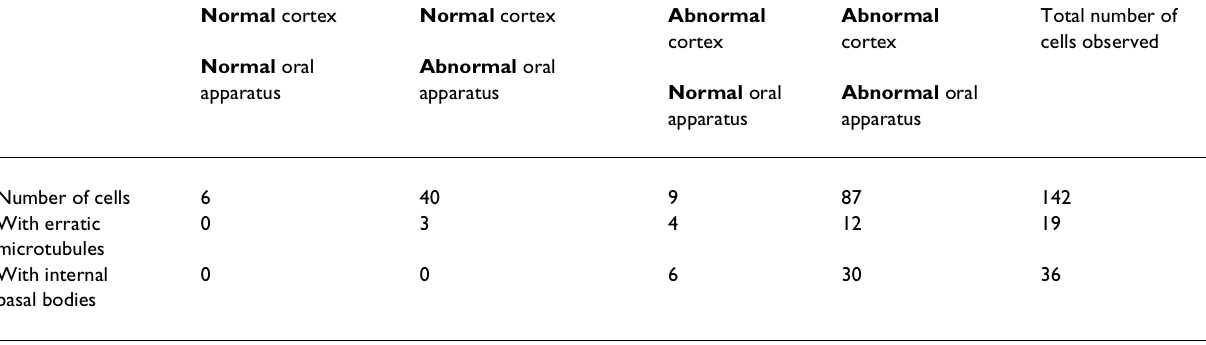
Table 1: Cytoskeletal abnormalities induced by binactivation of the δ PT1